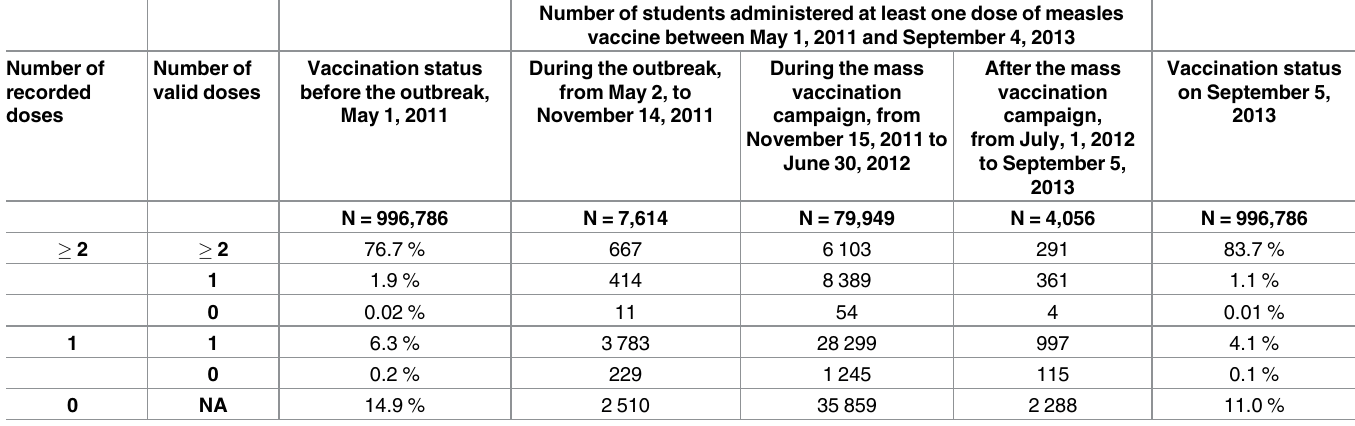
Table 1. Measlesvaccine coveragebefore the outbreak in May 2011and after the massvaccination campaign in September 2013 and number of students vaccinated during the outbreak and during and after the vaccination campaign. Number of students administered at least one dose of measles vaccine between May 1, 2011 and September 4, 2013 Number of